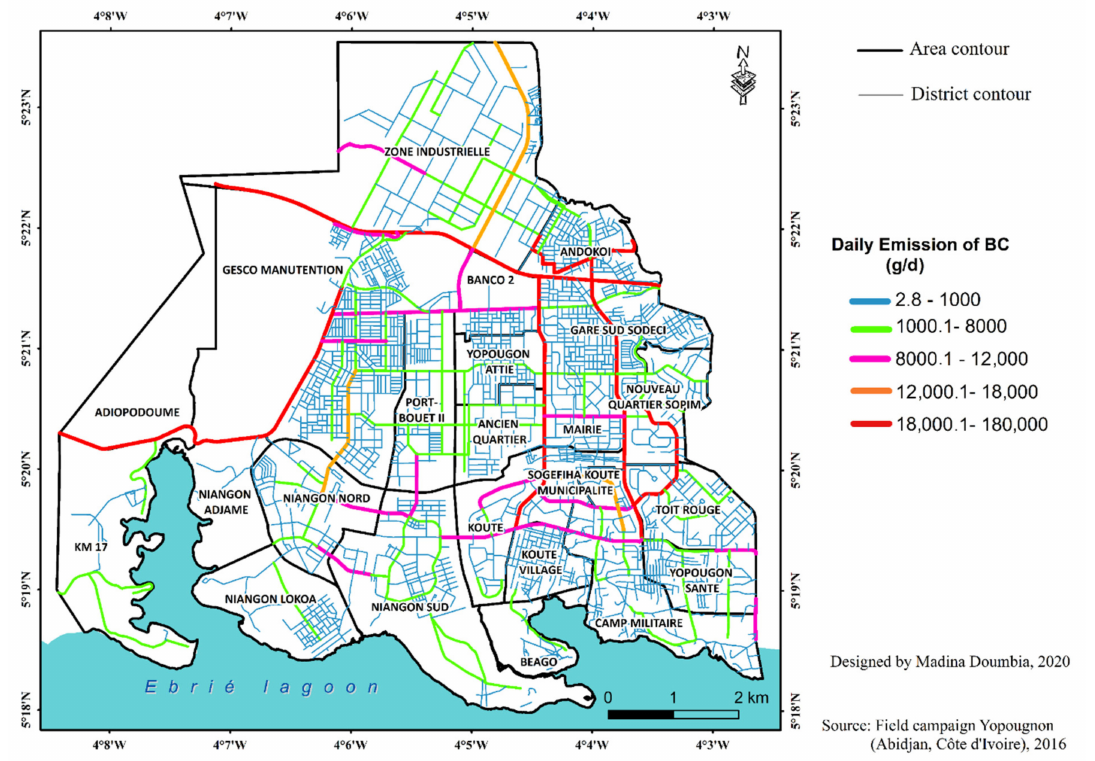
Figure 3. Spatial distribution of pollutant emissions of BC for the year 2016 in